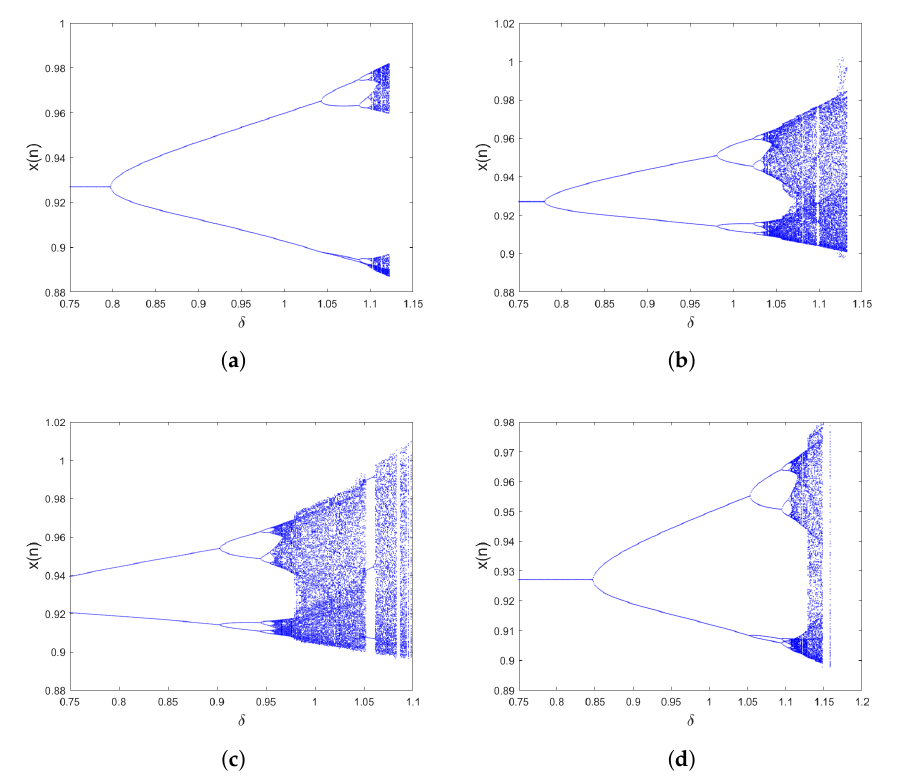
Figure 4. Bifurcations of (11) versus δ for ( a ) ( γ 1 , γ 2 ) = ( 0.7,0.9 ) , ( b ) ( γ 1 , γ 2 ) = ( 1,0.9 ) , ( c ) ( γ 1 , γ 2 ) = ( 0.9, 0.7), ( d ) ( γ 1 , γ 2 ) = ( 0.9,1 ) . Case 1. We vary the order γ 1 from 0.3 to 1 with step size ∆ γ 1 = 0.001. Figure 5a,b illustrates the bifurcation and its corresponding MILEs for γ 2 = 0.8, the parameter values a = 2.2, b = 55, c = 5.5, δ = 1.05 and initial conditions ( x ( 0 ) , y ( 0 )) = ( 0.9, 0.56 ) . It is clear from Figure 5 that the state of the incommensurate map (11) displays chaotic behavior for larger γ 1 values, as reflected by positive Lyapunov exponents, as seen in Figure 5b. The obtained MLE is 0.383. The Lyapunov exponent shown in Figure 5b is negative for the fractional order value γ 1 < 0.654. This result means that a small periodic region is seen for γ 1 ∈ [ 0.3, 0.654 ] . Moreover, when γ 1 grows larger and approaches 1, the incommensurate fractional map possesses a complex chaotic attractor as its MLEs reach their maximum